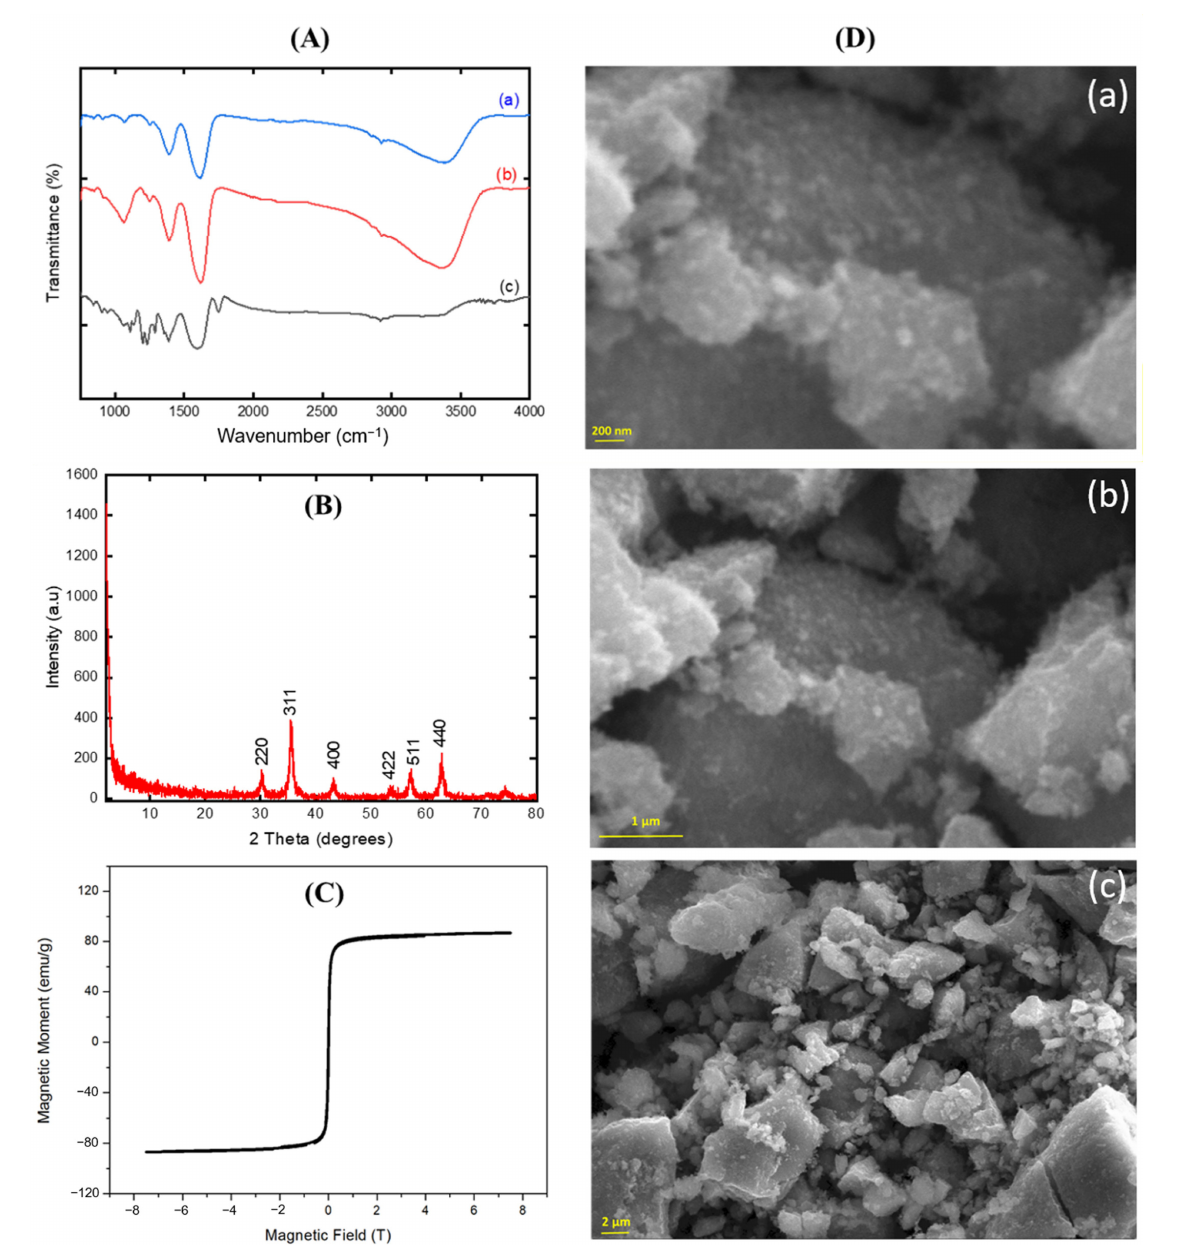
Figure 1. ( A ) FT-IR spectral comparison of (a) γ -Fe 2 O 3 -CA, (b) γ -Fe 2 O 3 -CA-Leu-Gly-CDP, and (c) γ -Fe γ -Fe 2 O 3 -CA-Leu-Gly-PDX, ( B ) XRD pattern of 2 O 3 -CA-Leu-Gly-PDX, ( C ) VSM magnetization curve of γ -Fe 2 O 3 -CA-Leu-Gly-PDX, and ( D ) SEM image of γ -Fe 2 O 3 -CA-Leu-Gly-PDX at different resolutions of (a) 200 nm, (b) 1 µ m, and (c) 2 µ